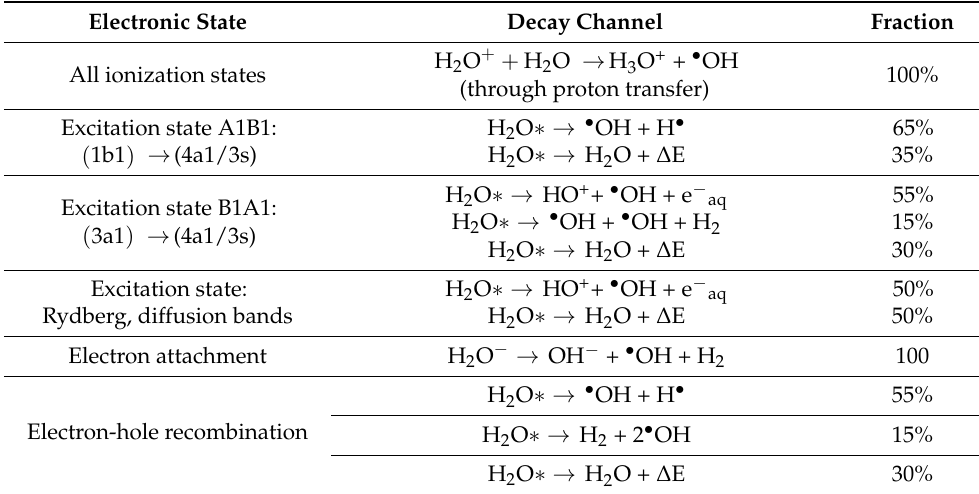
Table 2. Default decay channels and corresponding branching ratios of a water molecule until 1 ps as currently available in Geant4-DNA (the symbol * is used to represent excited water